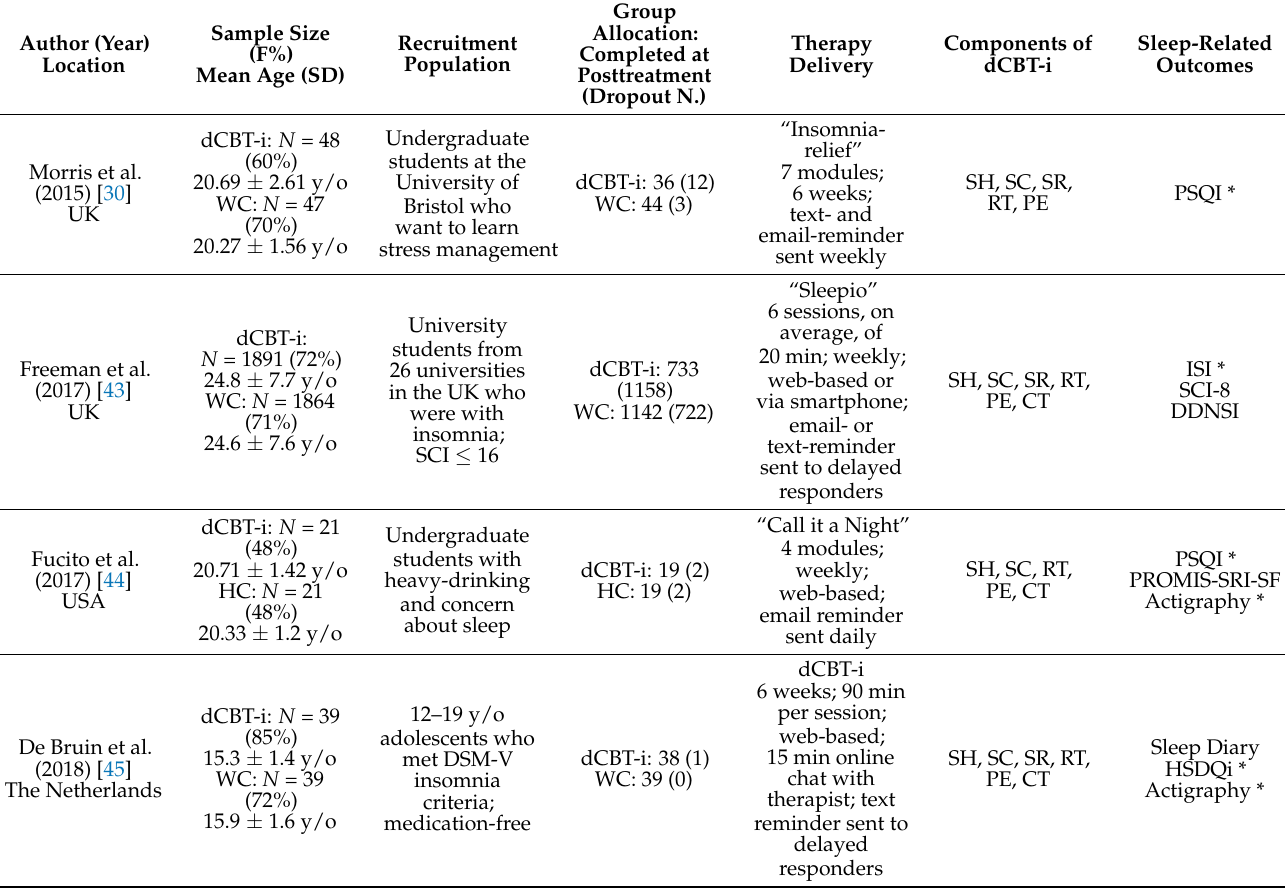
Table 2. Randomized controlled trials of digital cognitive behavioral therapy for insomnia enrolled for